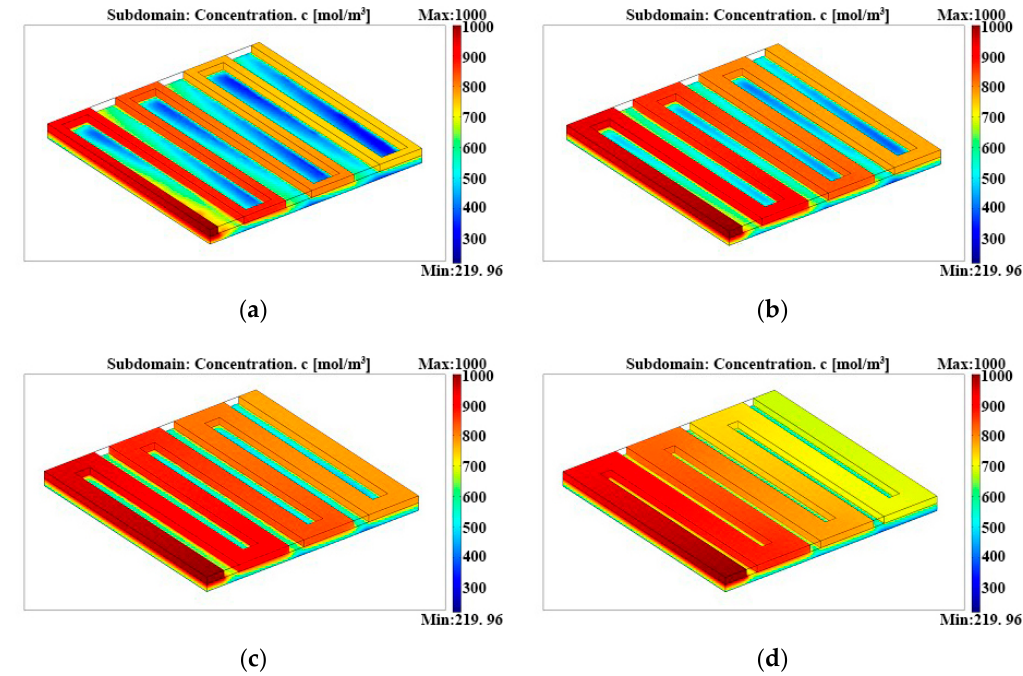
Figure 5. Methanol concentration distributions in the anode single-serpentine flow fields with different open ratios: ( a ) open ratio = 29.1%, ( b ) open ratio = 47.3%, ( c ) open ratio = 60.6%, and ( d ) open ratio = 73.0%.